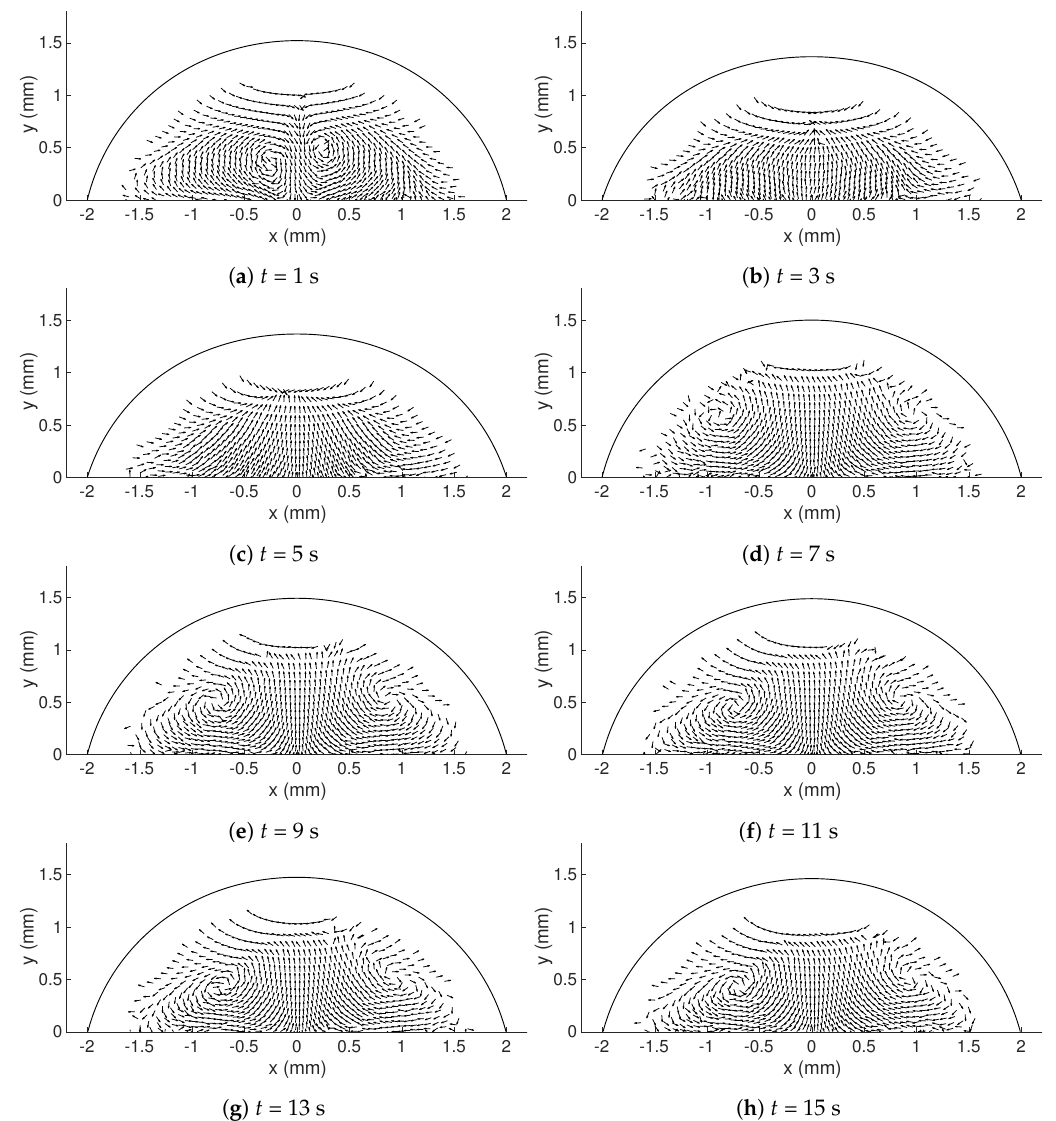
Figure 5. Internal flow patterns with normalized velocity vectors for the corrected data when T plate = 333.15 K (Case 1) at t = 1–15